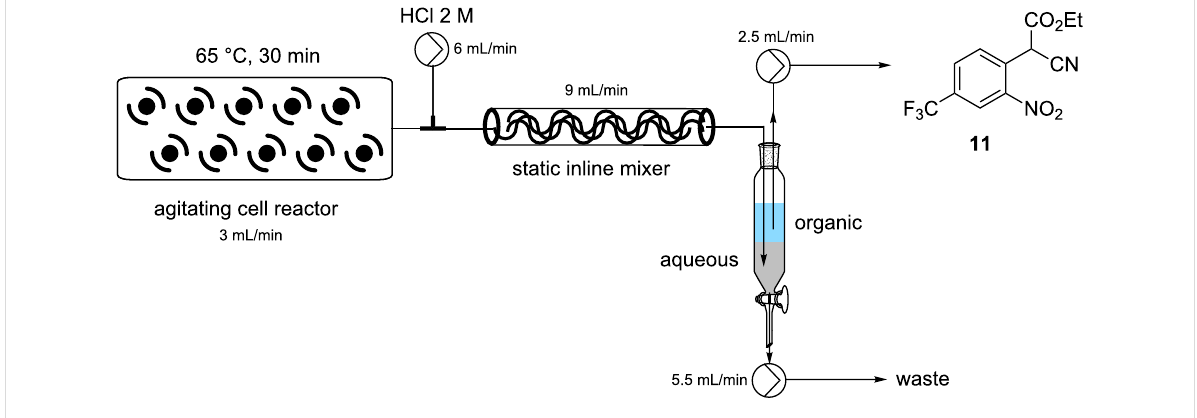
Scheme 4: Quenching and work-up of the reaction stream from the Coflore ACR for the synthesis intermediate 11 .